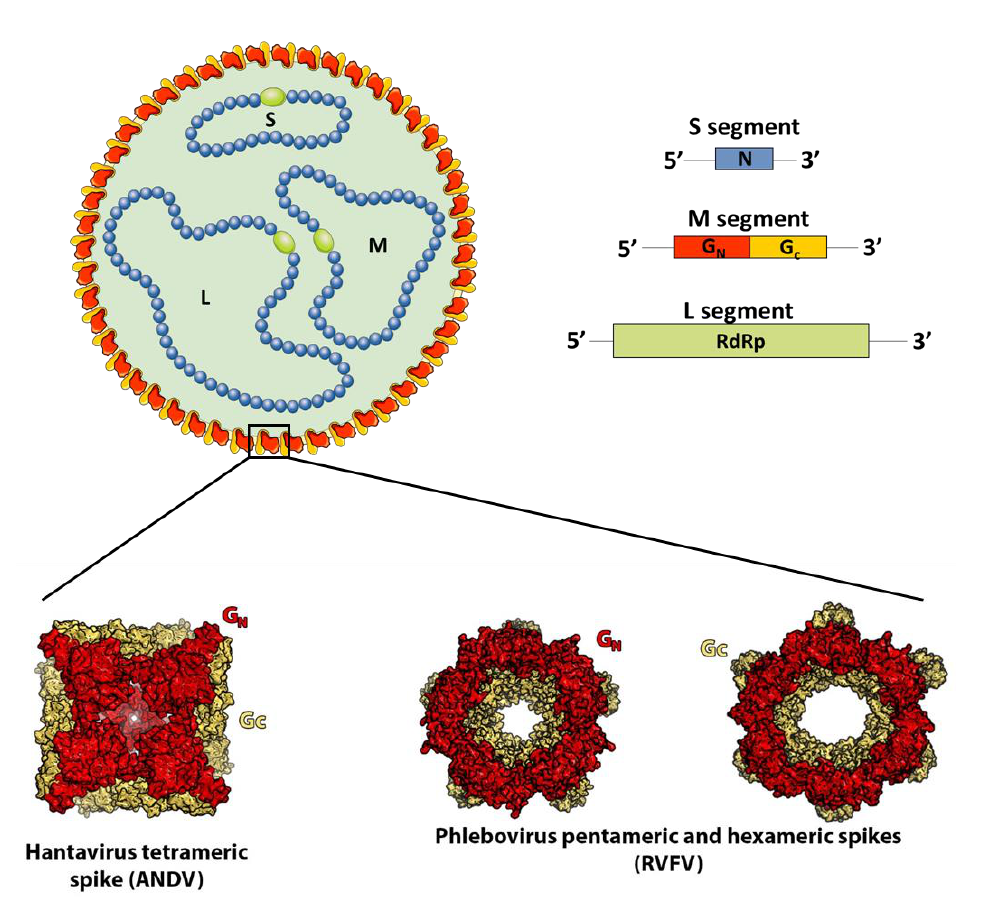
Figure 1. Schematic representation of a bunyavirus virion and main features of bunyavirus genomes ( Arenaviridae family excluded). The genomes of most families belonging to the Bunyavirales order are divided in three segments. Based on the length of their coding sequences, these genomic segments are named large (L), medium (M), and small (S). The L segment encodes the RNA-dependent RNA polymerase (RdRp protein), the S segment the nucleocapsid protein (N) that covers the genomic RNA, and the M segment codes for a glycoprotein precursor that is post-translationally cleaved into at least two structural proteins, termed Gn and Gc. In addition, depending on the bunyaviral family, the genomic segments encode additional proteins, in general non-structural, which are not represented here. The structures of hantavirus (PDB: 6ZJM) and phlebovirus (PDB: 6F9F and 6F9C) spikes obtained via X-ray crystallography are shown in the lower panel. Gn is in red, Gc in yellow. The atomic-level structure of nairovirus and orthobunyavirus spikes is not yet understood.